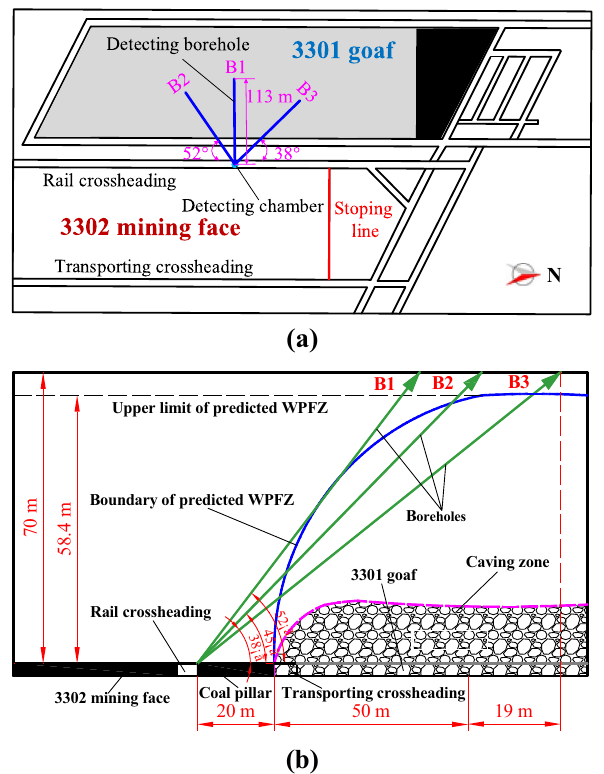
Figure 8. Layout of detection boreholes: ( a ) horizontal projection of detection boreholes, and ( b ) profile of the detection